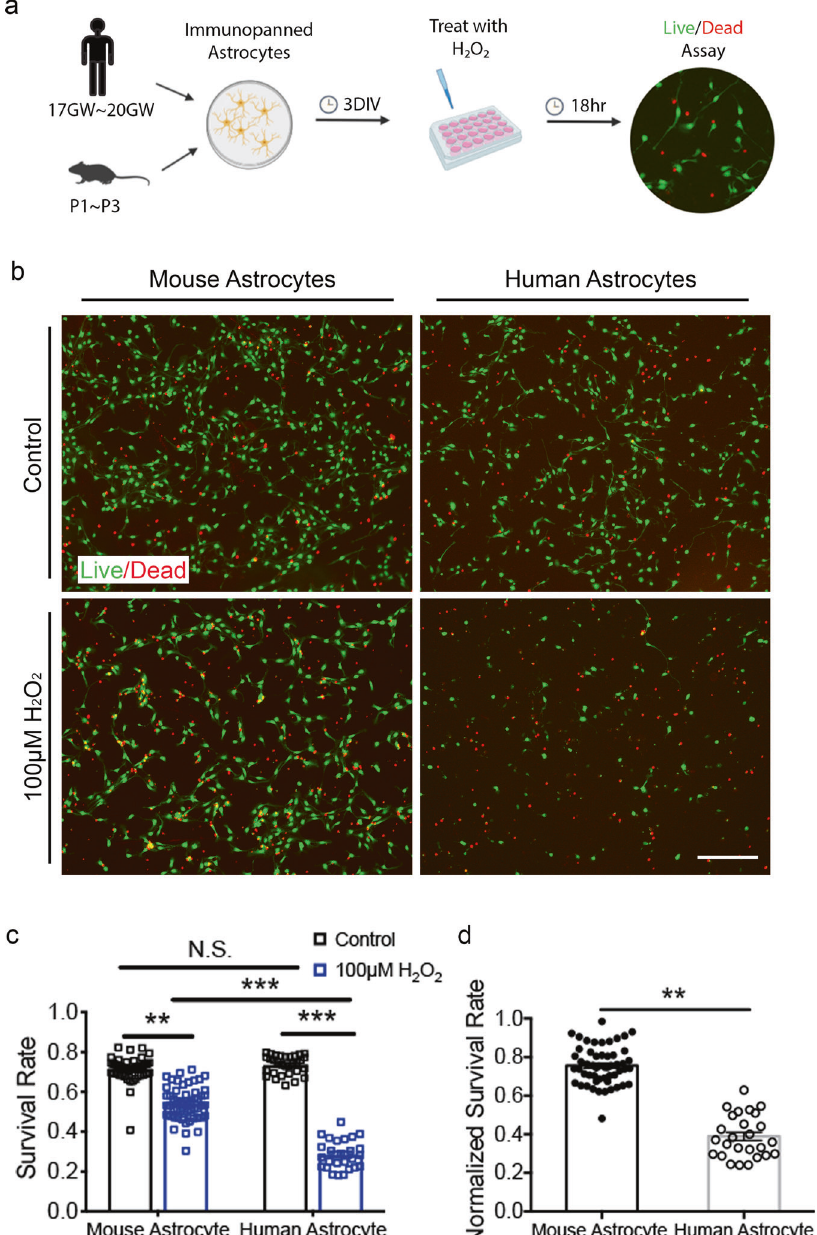
Fig. 3 Human astrocytes are more susceptible to oxidative stress than mouse astrocytes. a Experimental design. Hr, hour. b Human and mouse astrocytes treated with H 2 O 2 or medium control stained with the live cell dye calcein-AM (green) and the dead cell dye ethidium homodimer (red). Scale bar: 200 μ m. c Survival rate. Mouse astrocytes: N = 50 images from 12 cultures treated with medium control and 54 images from 12 cultures treated with H 2 O 2 generated from 6 litters of mice. Human astrocytes: N = 31 images from 7 cultures treated with medium control and 26 images from 6 cultures treated with H 2 O 2 generated from 3 patients. Data are presented as mean ± SEM in all fi gures, unless otherwise indicated. Mouse astrocytes: control vs. H 2 O 2 , p = 0.0039. H 2 O 2 -treated mouse astrocytes vs. H 2 O 2 -treated human astrocytes, p = 0.0002. Human astrocytes: control vs. H 2 O 2 , p < 0.0001. * p < 0.05, ** p < 0.01, *** p < 0.001 in all fi gures. Two-way analysis of variance (ANOVA) with Tukey ’ s test for multiple comparisons. N.S., not signi fi cant. The p - values were calculated using average results from each litter of mice and each patient as independent observations, unless otherwise indicated. d Survival rate of astrocytes treated with H 2 O 2 normalized to the survival rate of medium control-treated cells. Replicate numbers N are de fi ned in ( c ). p = 0.0096. Two-tailed unpaired Welch ’ s t [reads per kilobase per million mapped reads (RPKM): acutely and mouse astrocytes by immunopanning 26,28,41 and per- puri fi ed, 2.04±0.24 for human astrocytes and 5.67±0.38 for formed RNA-seq immediately after puri fi cation and after mouse astrocytes; in vitro, 1.14±0.10 for human astrocytes and 5 – 6 days of culture in serum-free conditions (this study). We 7.60±0.71 for mouse astrocytes; Fig. 5a]. An additional mole- found that the gene encoding a major peroxisomal ROS cular pathway, the pentose phosphate pathway, produces detoxi fi cation enzyme, catalase 42 , is expressed at 3 – 6-fold NADPH, which neutralizes ROS 43 . The rate-limiting step of the higher levels by mouse astrocytes than by human astrocytes